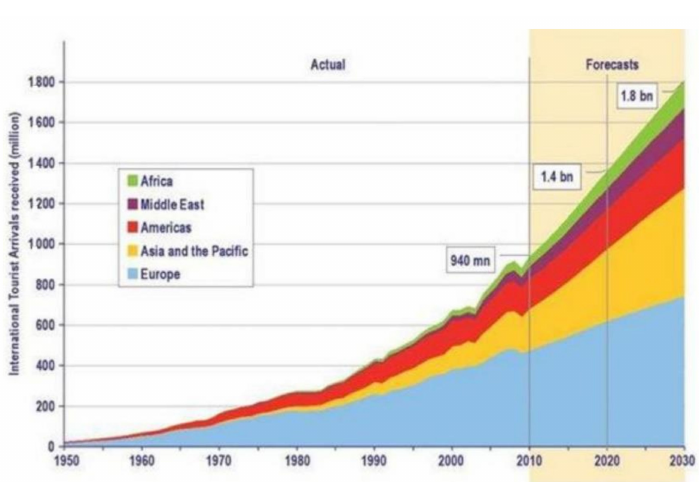
Figure A2. UNWTO prediction. Tourism towards 2030: Actual trend and forecast 1950–2030